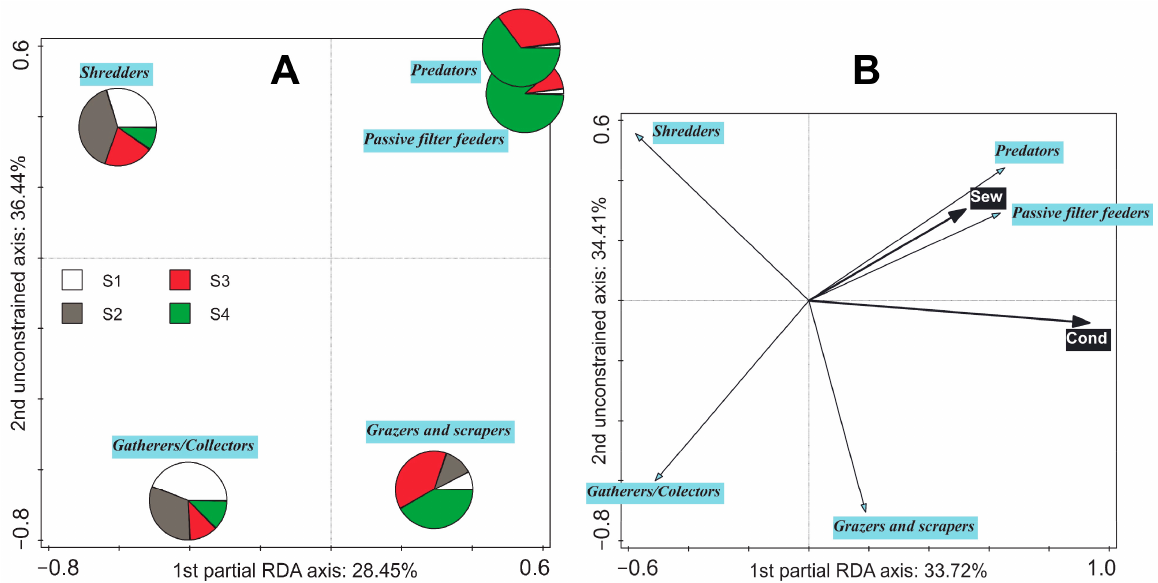
Figure 5. ( A ) Averaged feeding strategies pie chart and ( B ) Averaged feeding strategies + whole-plot environmental variables (EVs) biplot. Partial Redundancy analyses (RDA) were used. First ordination axes were constrained: ( A ) by the factor ‘Site’ that accounted for 30.98% of the explained variation and ( B ) by the EVs selected by forward selection, which accounted for 38.91% of the explained variation. ( A ) Test on first axis: pseudo- F = 5.4, p = 0.003; test on all axes: pseudo- F = 6.1, p = 0.026; ( B ) test on first axis: pseudo- F = 2.5, p = 0.006; test on all axes: pseudo- F = 5.7, p = 0.009. Conditional effects (from the greatest to the lowest explained variation): ( A ) ‘Site 4 (S4)’ explained variation = 22.0%, pseudo- F = 12.1, p (adj.) = 0.027; ‘Site 3 (S3)’ explained variation = 8.6%, pseudo- F = 5.2, p (adj.) = 0.090; and ‘Site 2 (S2)’ explained variation = 0.3%, pseudo- F = 0.2, p (adj.) = 0.943. ( B ) ‘Conductivity (Cond)’: explained variation = 32.5%, pseudo- F = 20.7, p (adj.) = 0.005 and ‘Total volume of released sewage for three days prior to sampling time (Sew)’: explained variation = 6.4%, pseudo- F = 4.4, p (adj.) = 0.045.